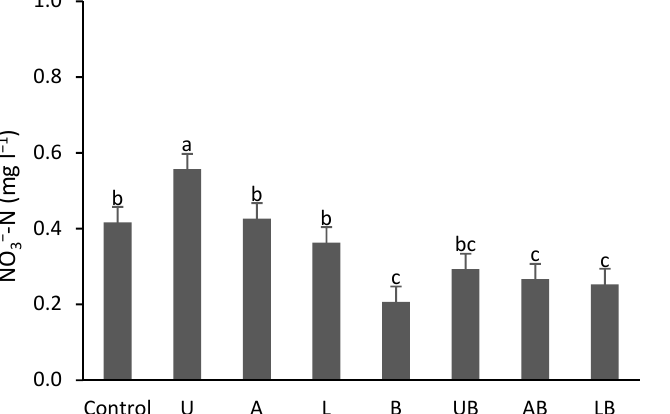
Figure 4. Changes in nitrate leaching status with applying different N-source treatments. Significant differences of means are shown by different lowercase letters.